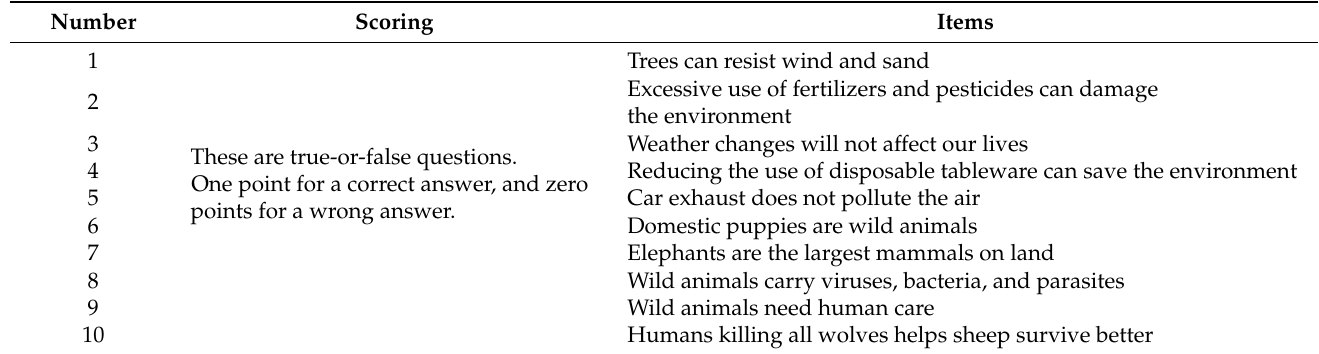
Table A2. The scale of children’s environmental knowledge.